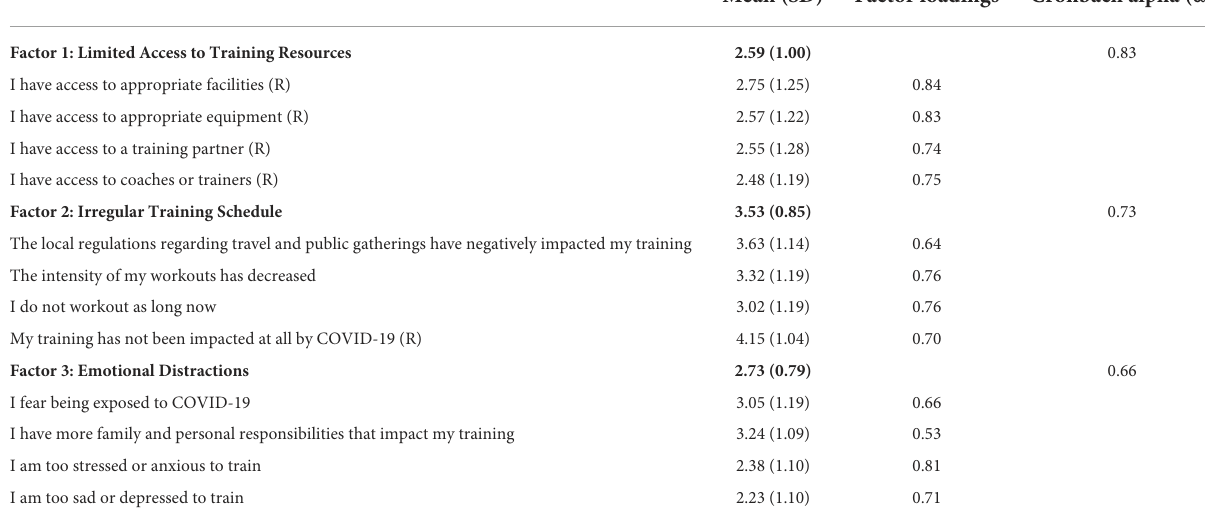
TABLE 2 Factor loadings, means and standard deviations, and reliability scores for the Barriers to Training